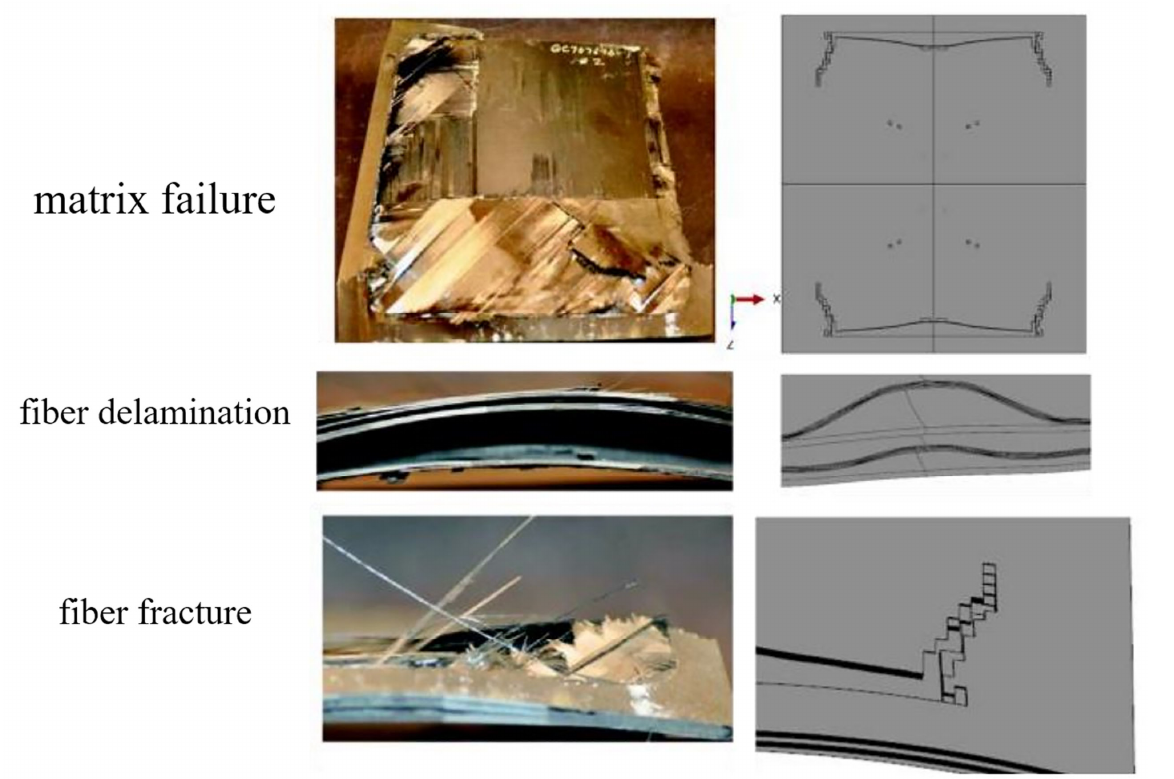
Figure 9. Comparison between experimental and simulation deformation modes.